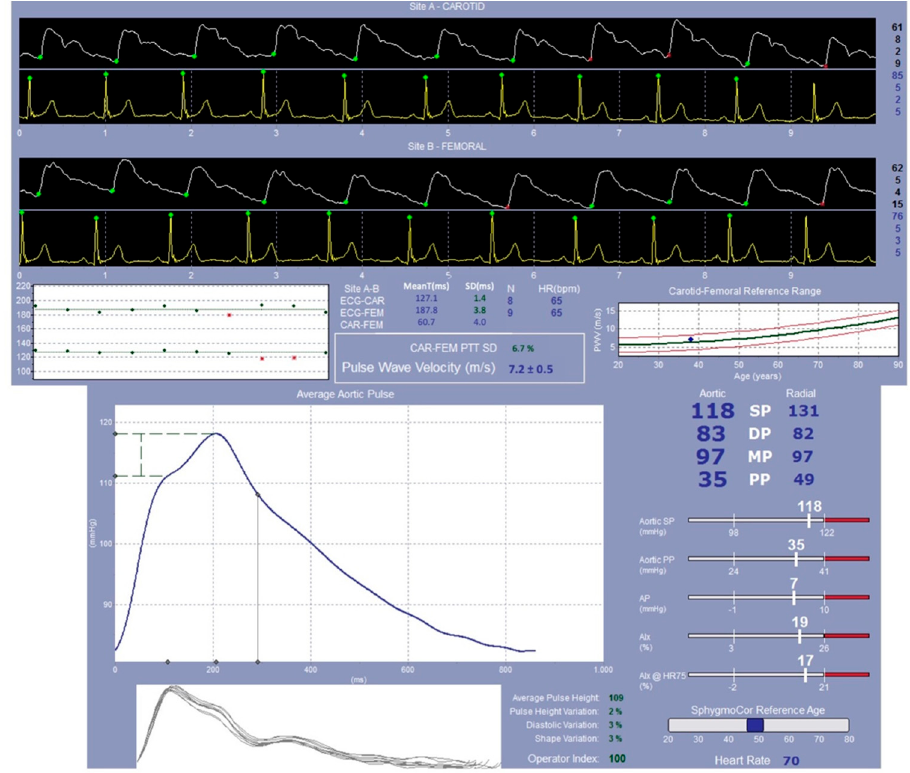
Figure 5. Schematic representation of SphygmoCor CvMS carotid-femoral pulse wave velocity (cf- PWV) measurement method with sequential applanation tonometry of the carotid (marked as a red square) and femoral (marked as a red arrow) sites. Pulse transit times (tt) are calculated from the electrocardiogram (ECG) R-wave to the foot of the applanated waves. Distances (d) are measured from the suprasternal notch (s) to the sites of applanation tonometry. Modified from Butlin and Qasem, 2016; © 2016 by S. Karger AG, Basel [60].